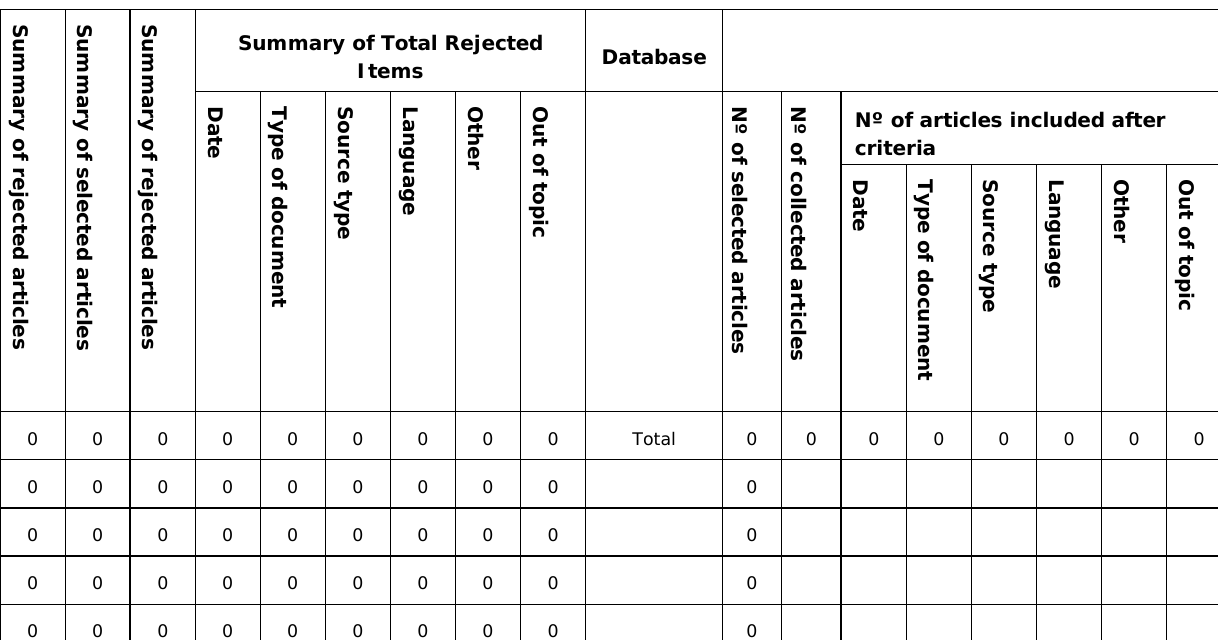
Table A1. Form sheet summarizing the proposed rejection